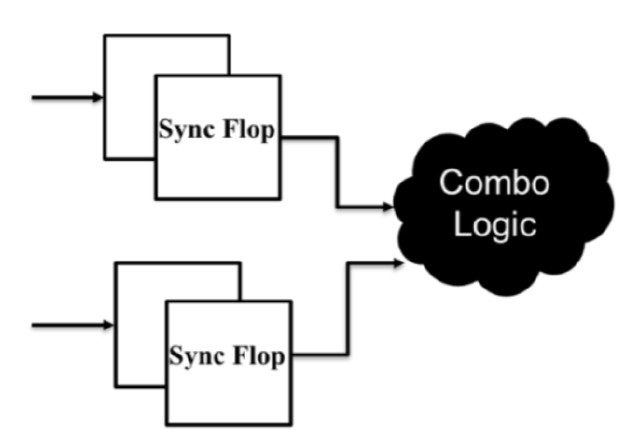
Figure 6. Convergence issue inside the IP